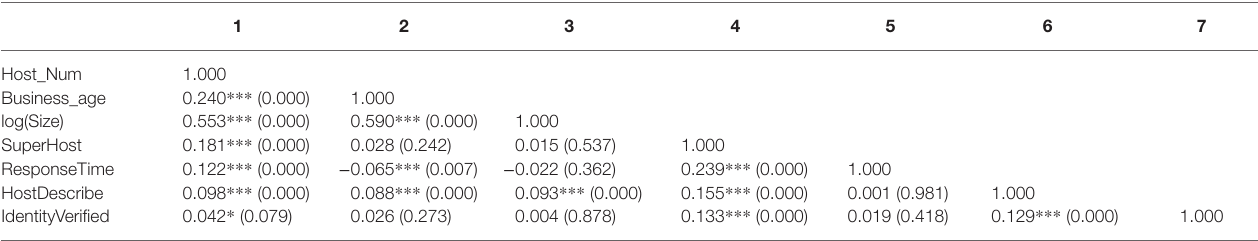
TABLE 2 | Correlation coefficient matrix.